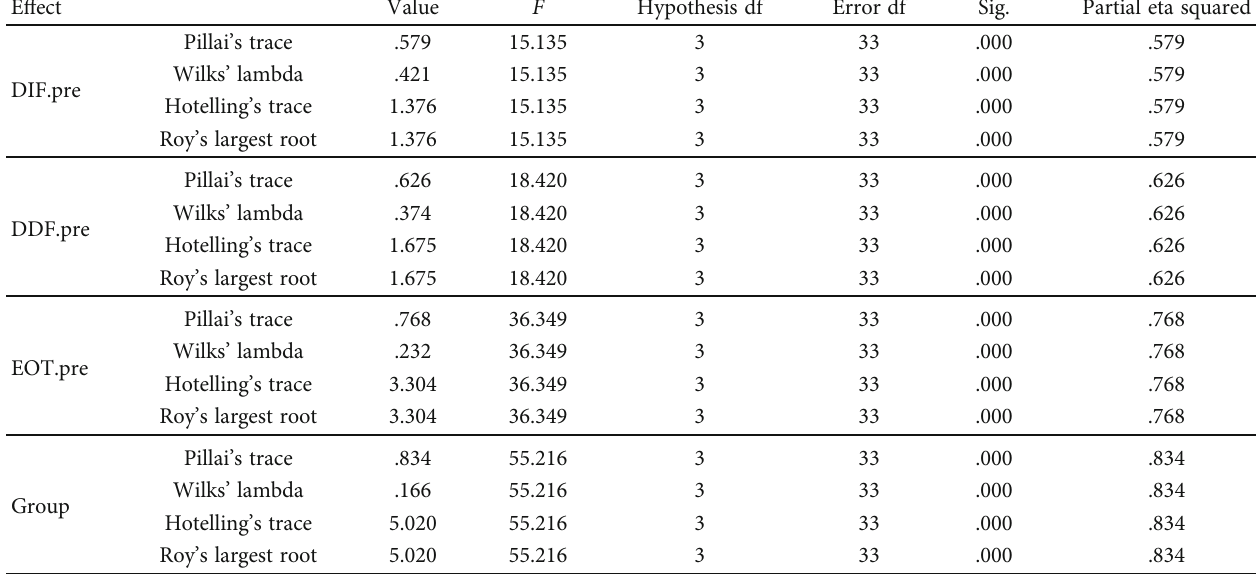
Table 6: Multivariate